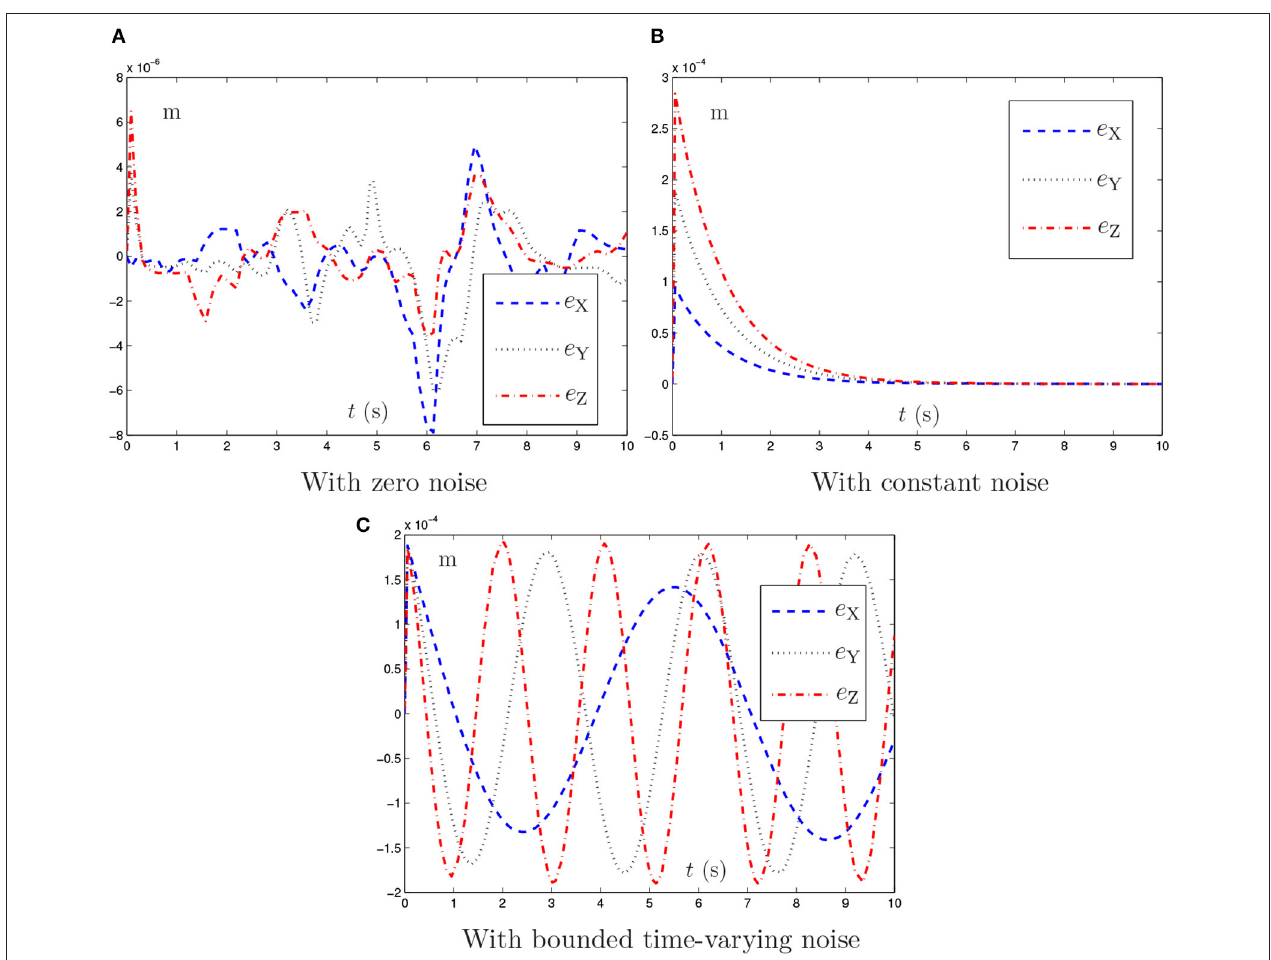
FIGURE 8 | Trajectories of Cartesian error e ( t ) synthesized by the proposed NTOA scheme (6) with three situations considered, which corresponds to Figure 7 .